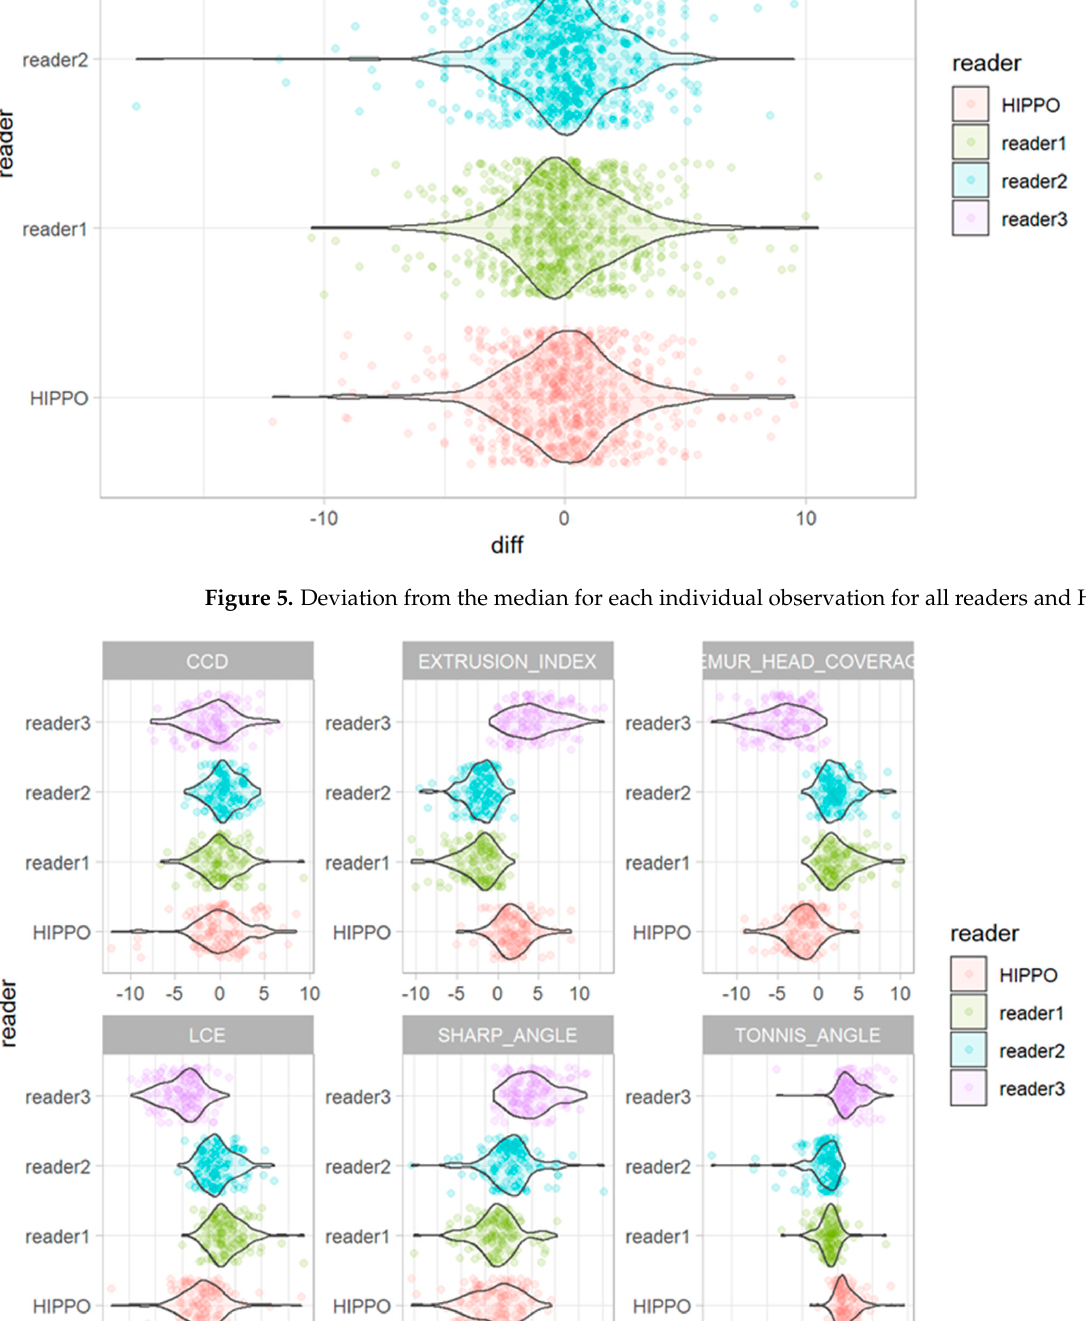
Figure 7. Absolute deviation from the median for each individual observation for all readers and HIPPO™.